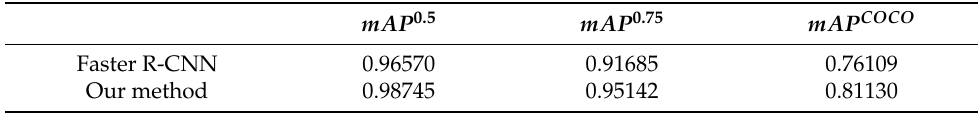
Table 3. mAP 0.5 , mAP 0.75 , and mAP coco on testing dataset.